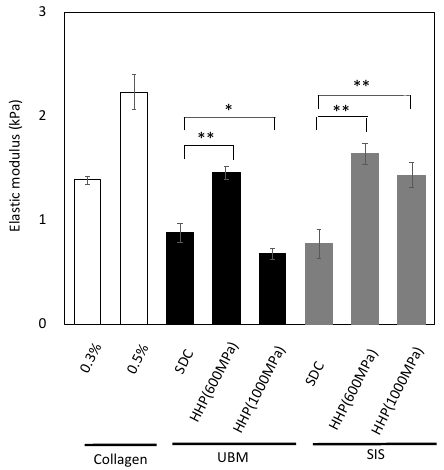
Figure 6. Elastic modulus at 10% strain range of collagen hydrogels and d-ECM hydrogels. * p < 0.05, ** p < 0.01. SDC and HHP represent the method of decellularization of each tissue (urinary bladder matrix (UBM) and small intestine submucosa (SIS)).